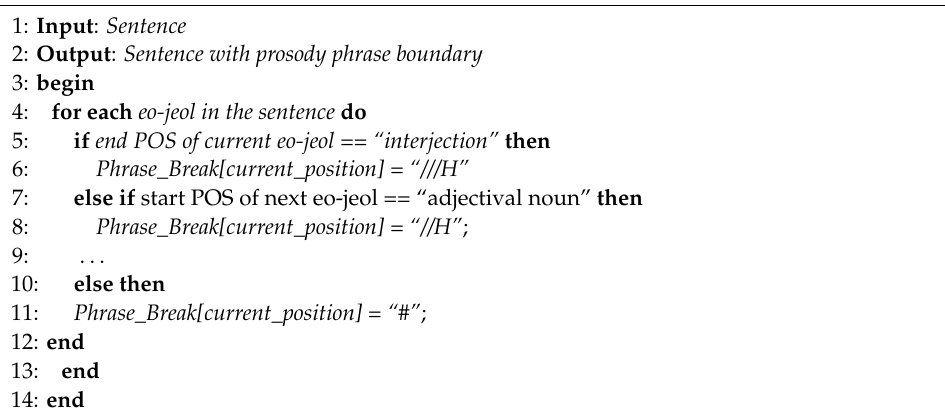
Algorithm 1 Prediction of prosody phrase boundary using syntactic